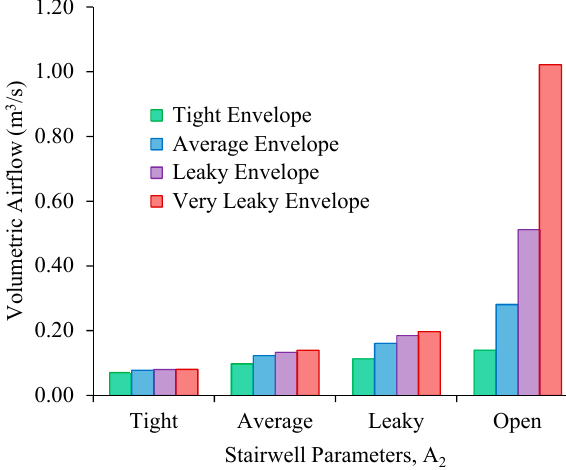
Figure 9. Airflow into the 1st floor stairwell for tight, average, and leaky envelopes.